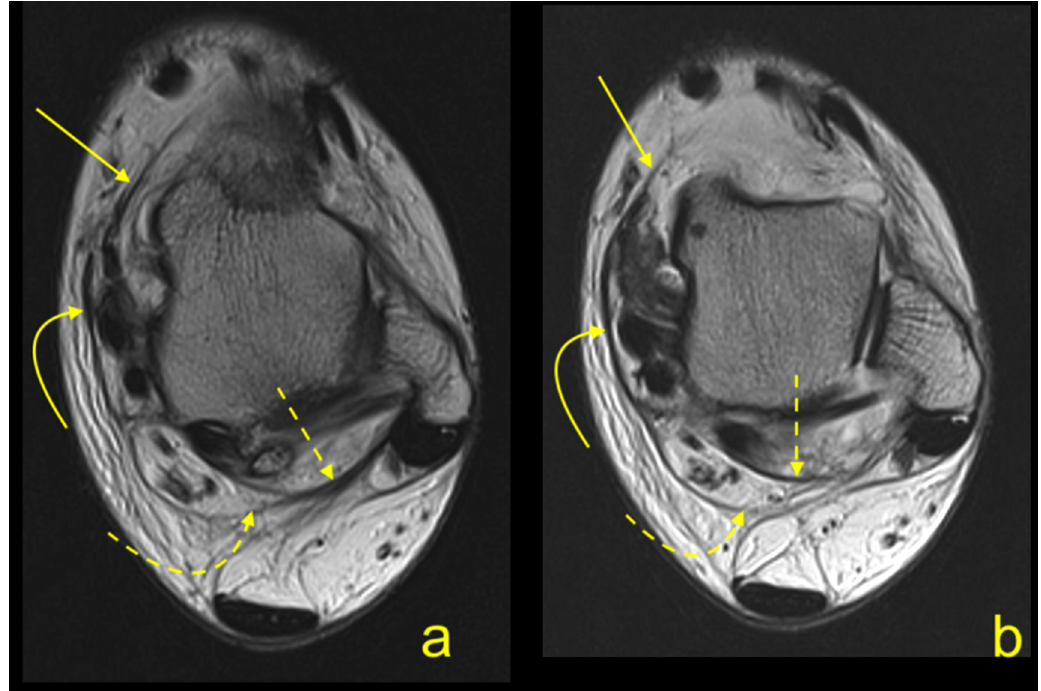
Figure 3. ( a , b )—a 39-year-old patient with clinical suspicion of posterior impingement. ( a , b )—PD weighted images. FR (curved arrow) communicates with the inferior extensor retinaculum (IER) (straight arrow). Posterior FR gives projection (curved dashed arrow) to fibulotalocalcaneal ligament (FTCL) (dashed arrow).